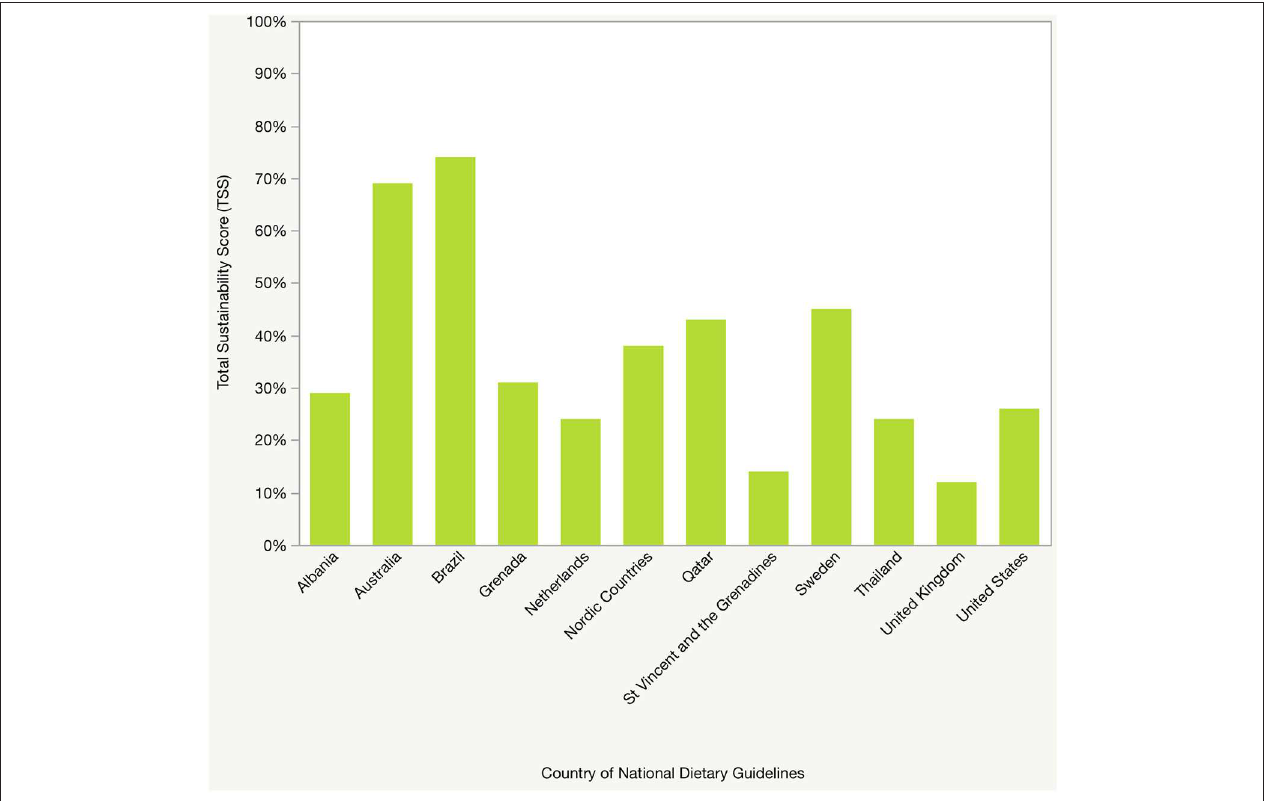
FIGURE 6 | Variation of total sustainability dimension scores (TSS) between national dietary guidelines. This figure demonstrates the variation of total sustainability dimension scores comprised of the 32 sub-dimensions of sustainability in the 12 national dietary guidelines evaluated in this